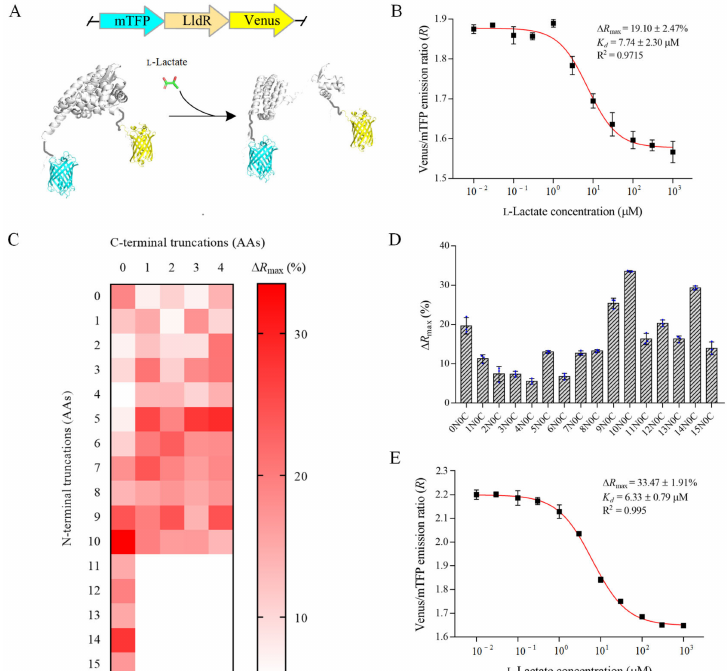
Figure 2. Design and optimization of FILLac. ( A ) Schematic representation of the predicted conforma- tional changes of the L -lactate biosensor FILLac in the presence or absence of L -lactate. The structure of ST LldR shown was predicted based on its amino acid sequence, and the structures of mTFP and Venus shown were downloaded from PDB (PDB ID: 4R6D for mTFP and 3AKO for Venus). ( B ) Dose-response curve of FILLac 0N0C for increasing concentration (10 nM to 1 mM) of L -lactate. The flu- orescence emission ratio (Venus to mTFP) of FILLac 0N0C decreased after L -lactate binding. ( C ) Heat map of variants with N-terminal or C-terminal amino acid truncations of ST LldR to ∆ R max . The color indicates the value of ∆ R max , and white indicates undetected variants. ( D ) Comparison of the ∆ R max of biosensor variants based on the N-terminal amino acid truncation of ST LldR. ( E ) Dose-response curve of the optimized variant FILLac 10N0C for increasing concentration (10 nM to 1 mM) of L -lactate. All data shown are mean ± s.d. ( n = 3 independent